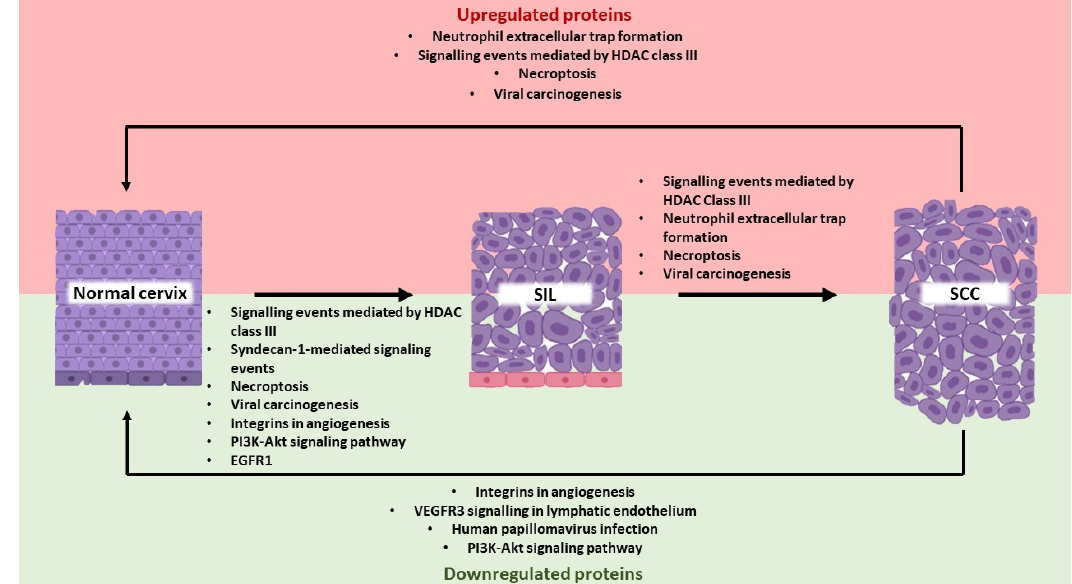
Figure 6. Summary of the pathways involved in the development of cervical cancer. The figure illustrates the upregulated (pink region) and downregulated pathways (green region) involved in cervical carcinogenesis, from normal cervix to SIL and SCC. The main signaling events mediated by HDAC Class III, necroptosis, and viral carcinogenesis are downregulated in the transformation from the normal cervix to SIL, which then become upregulated during the progression from SIL to SCC. The same pathways are also found to be upregulated in SCC compared to normal cervix, suggesting that their activation pathways trigger cancer formation. In contrast, the PI3K-Akt signaling pathway and integrins in angiogenesis are downregulated in the transition from normal cervix to SIL, as well as in SCC compared to normal cervix, which are involved in cell proliferation, growth and metastasis.